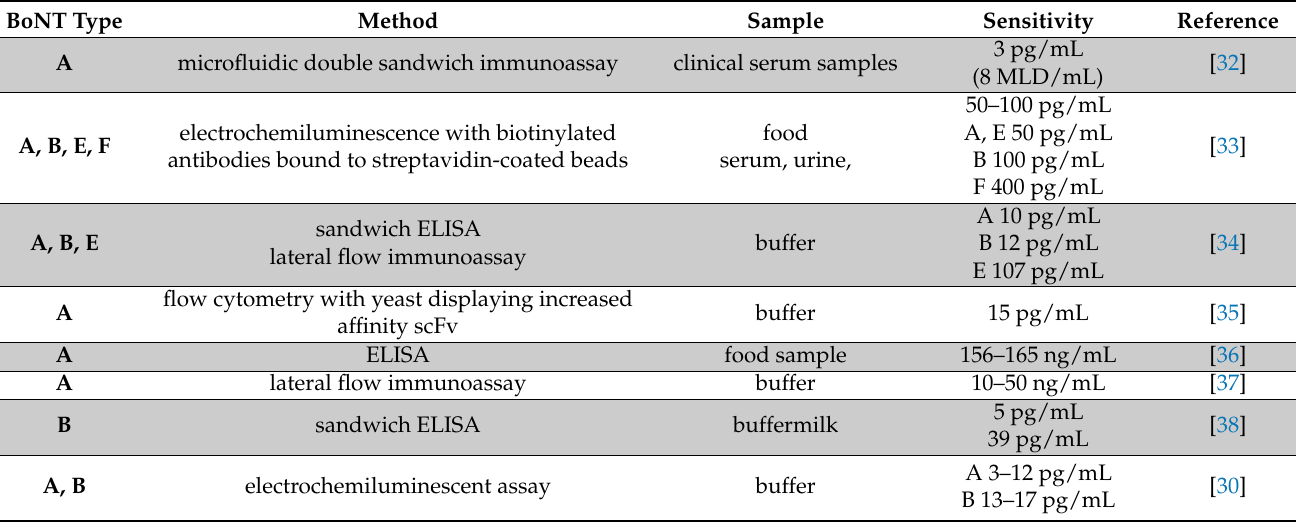
Table 1. Representative immunological-based methods of BoNT detection and their